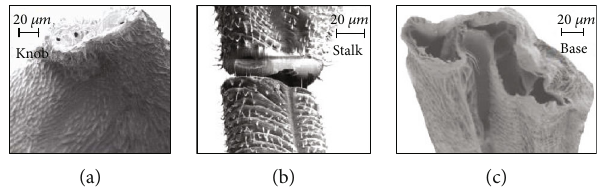
Figure 14: Cross-sectional view of the haltere (a) at the knob, (b) at the stalk, and (c) at the base [14].